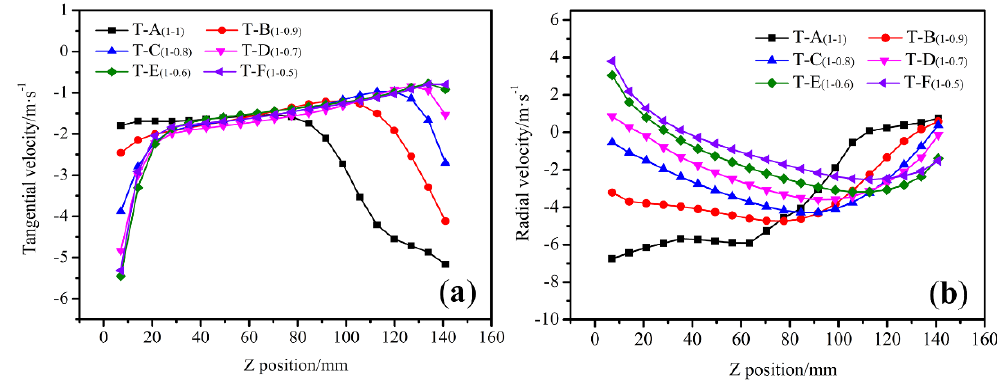
Figure 4. Velocity distribution on the outer surface of the rotor cage: ( a ) tangential velocity and ( b ) radial velocity.